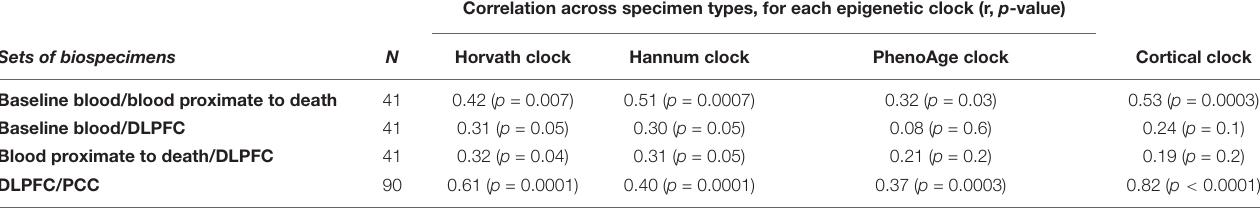
TABLE 2 | Pearson correlations of epigenetic clocks across blood samples and brain regions. Correlation across specimen types, for each epigenetic clock (r, p -value)